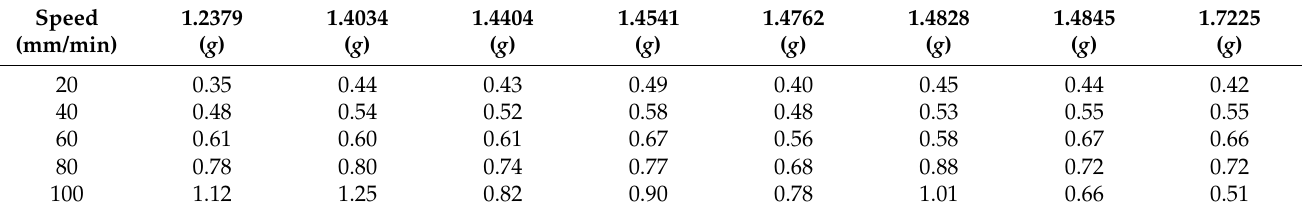
Table 12. Vibrations measured in the x -axis in relation to the respective steel and the traverse speed.